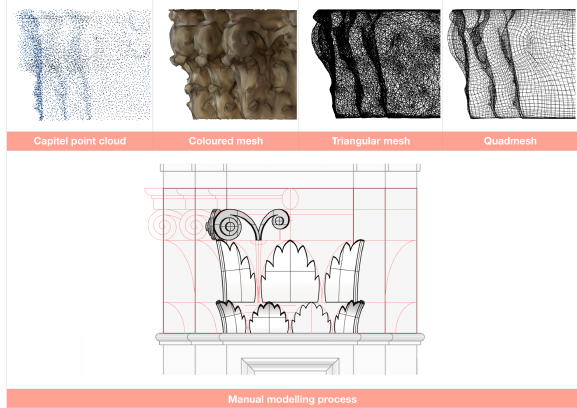
Figure 5. Semi-automatic and manual modelling of a